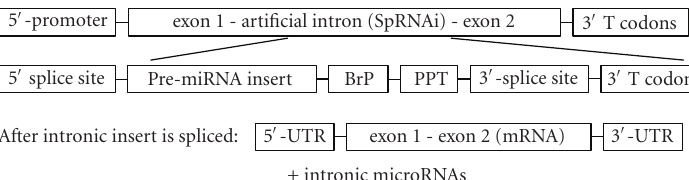
Figure 3: Schematic construct of the artificial SpRNAi intron in a recombinant gene SpRNAi-RGFP for intracellular expression and pro- cessing. The components of the Pol-II-mediated SpRNAi system include several consensus nucleotide elements consisting of a 5 (cid:2) -splice site, a branch-point domain (BrP), a poly-pyrimidine tract (PPT), a 3 (cid:2) -splice site, and a pre-miRNA insert located between the 5 (cid:2) -splice site and the BrP domain. The expression of the recombinant gene is under the regulation of either a mammalian Pol-II RNA promoter or a compatible viral promoter for cell-type-specific e ff ectiveness. Mature miRNA molecules are released from the intron by RNA splicing and further Dicer